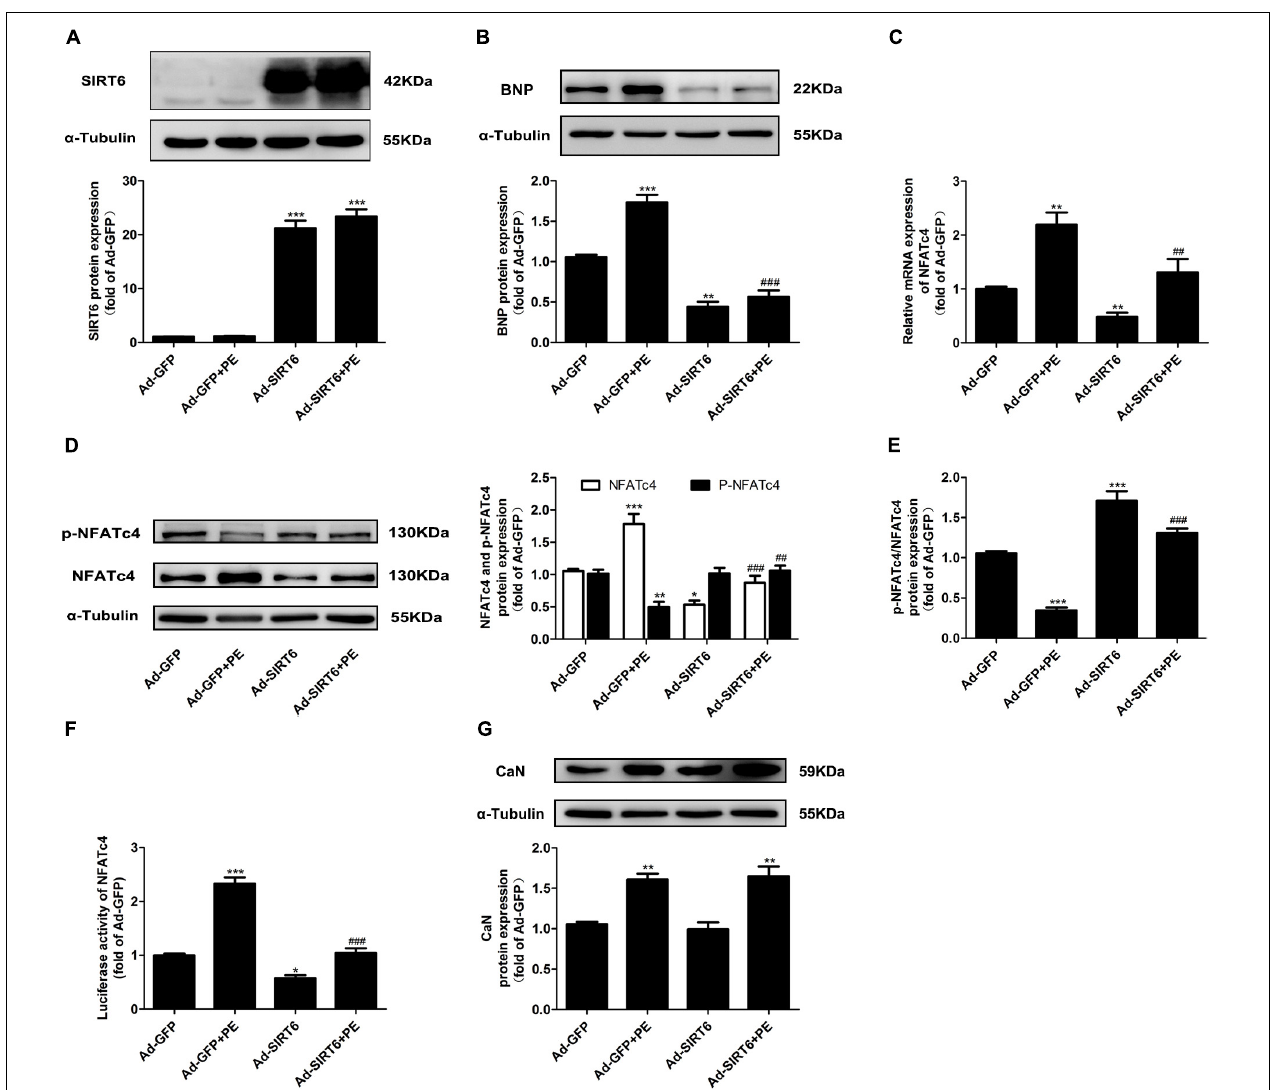
FIGURE 3 | SIRT6 overexpression suppressed the expression level and dephosphorylation of NFATc4. NRCMs were infected with adenovirus vector encoding SIRT6 cDNA for 48 h. (A,B) The protein expression of SIRT6 and BNP were determined by Western blot analysis. (C) The mRNA expression of NFATc4 was determined by qRT-PCR. (D) Total NFATc4 and phosphorylated NFATc4 were investigated by Western blotting. (E) The ratio of p-NFATc4/NFATc4 was determined. (F) Dual luciferase reporter assays evaluating NFATc4-dependent transcriptional activity. (G) The protein expression of calcineurin was studied in NRCMs treated with 100 µ M PE for 12 h. The data were presented as mean ± SEM. ∗ P < 0.05, ∗∗ P < 0.01, ∗∗∗ P < 0.001 vs. Ad-GFP. ## P < 0.01, ### P < 0.001 vs. Ad-GFP + PE, n = 4.